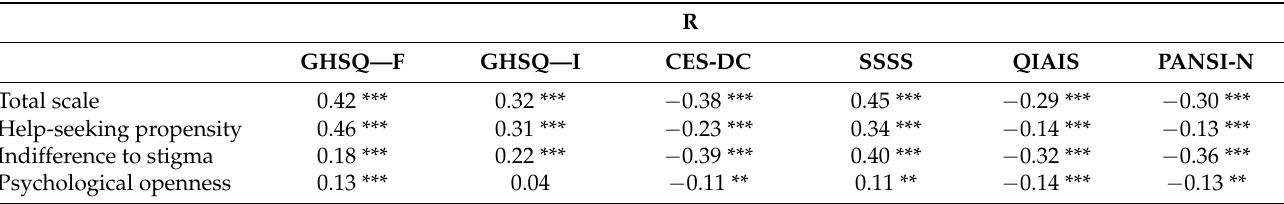
Table 3. Convergent and Discriminant Validity of the